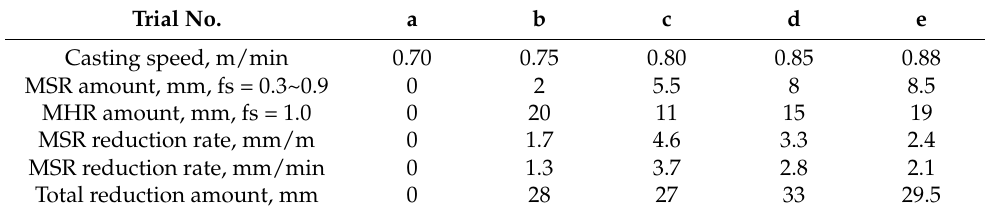
Table 2. Trial casting parameters of steel GCr15.